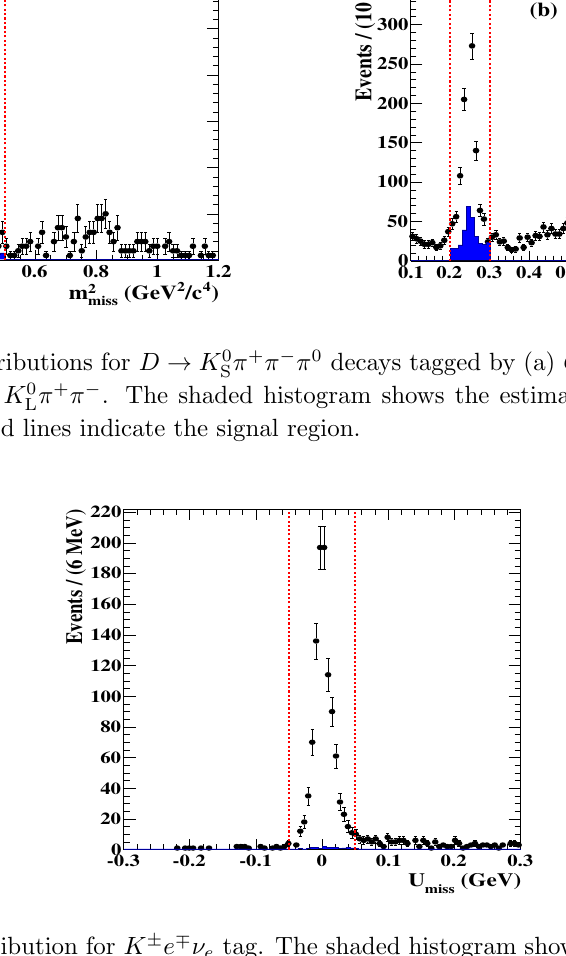
Figure 5 . U miss distribution for K (cid:6) e (cid:7) (cid:23) e tag. The shaded histogram shows the estimated peaking background and the vertical dotted lines indicate the signal